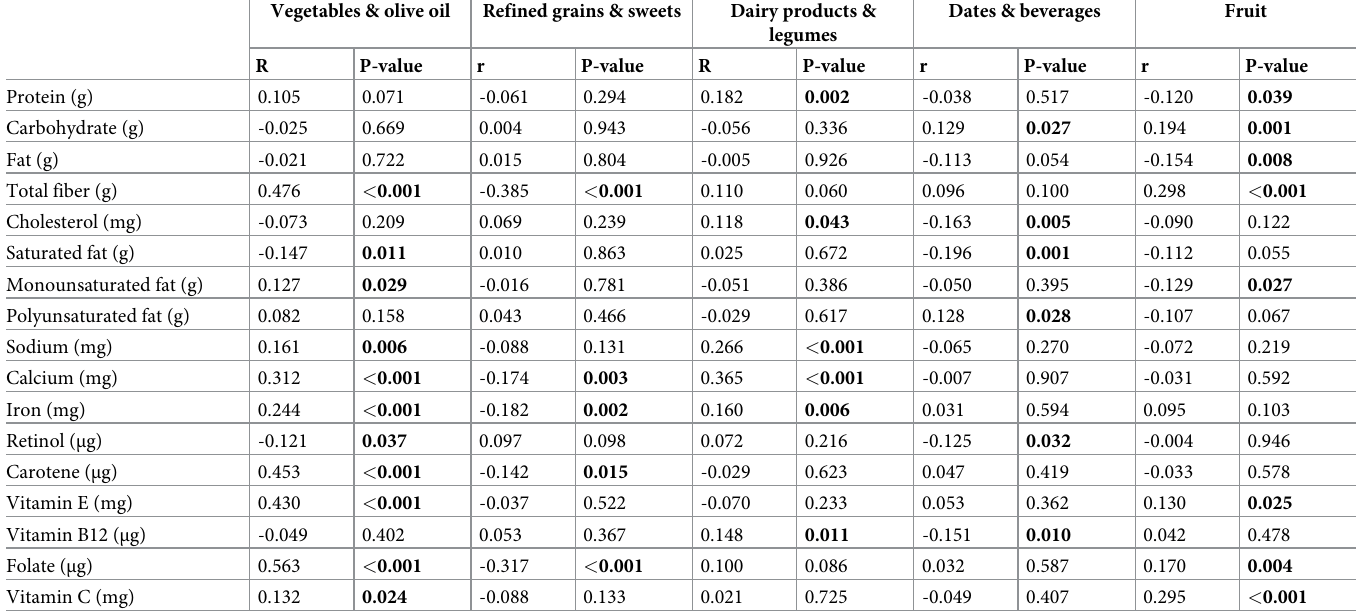
Table 4. Correlation between dietary pattern and diet composition a